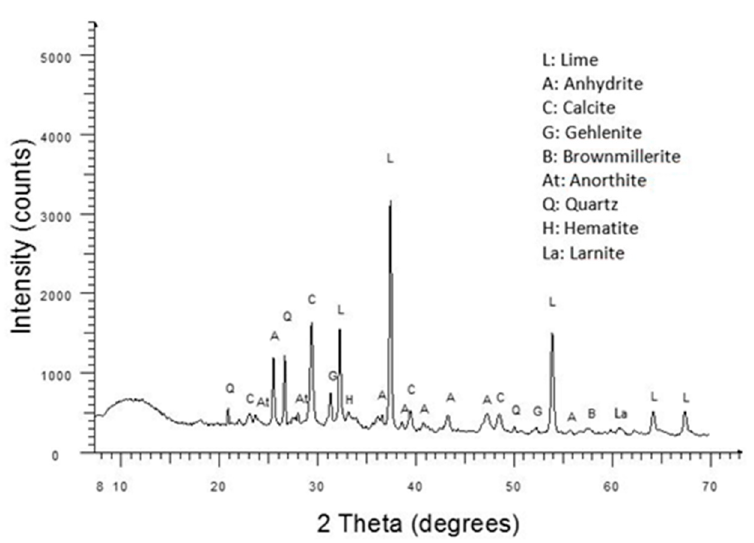
Figure 4. XRD pattern of quarry dust.